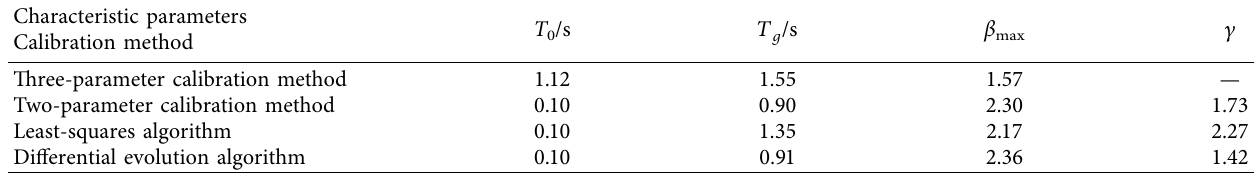
Table 4: List of characteristic parameters of the traditional response spectrum.